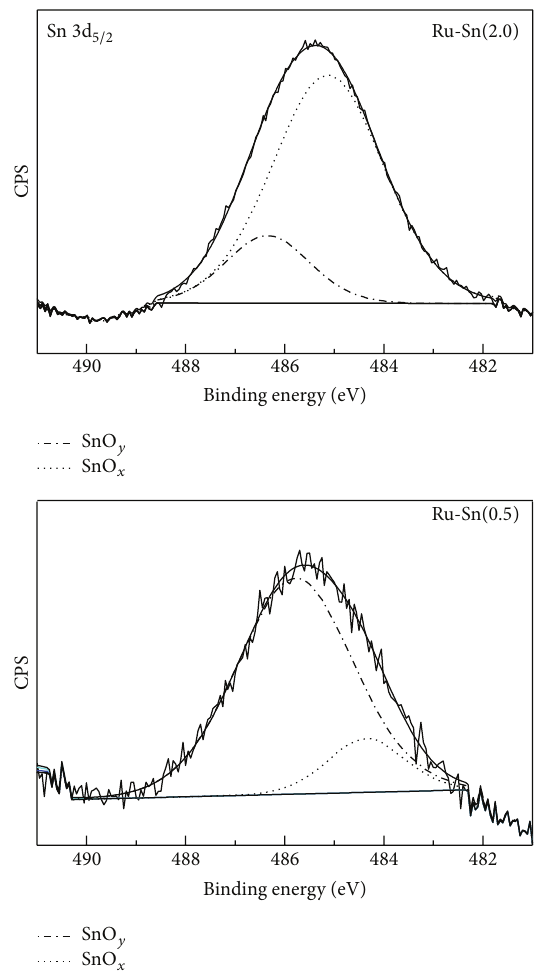
Figure 5: XPS spectra of the bimetallic catalysts in the energy range of the Sn 3d 5/2 core